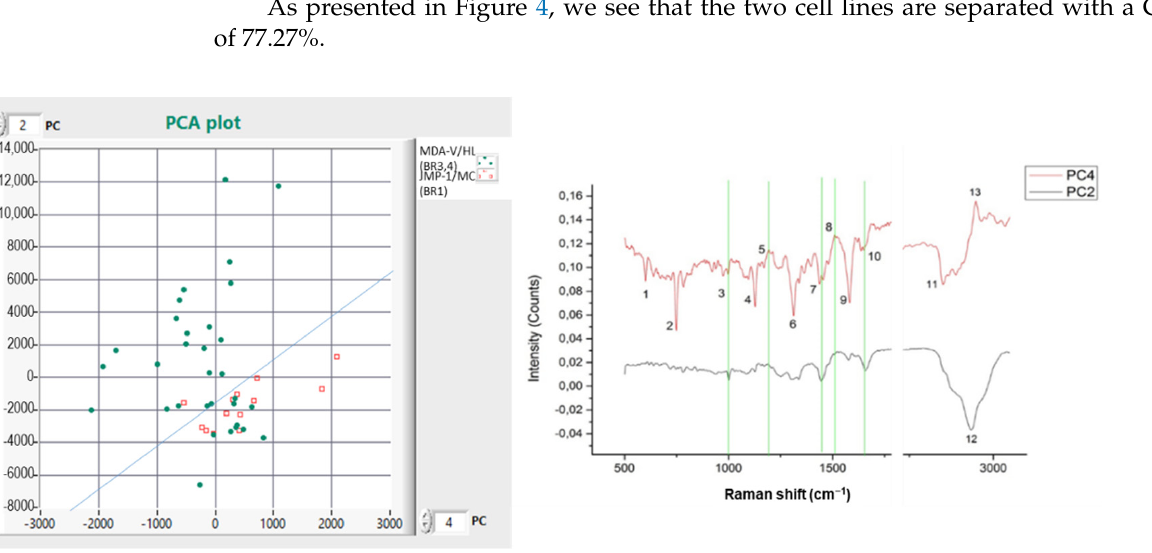
Figure 4. ( left ) Comparison between experiments BR1 (JMP-1/MCL NHL) and BR3,4 (MDA-V/HL) cell lines; ( right ) PCA Raman spectra showing the cell lines differences. Further, the major Raman peaks identified are presented in Table 3. Major Raman peaks found in PCA between BR1 and BR3, 4. In red color and with an aster- isk superscript the temperature dependent Raman peaks are presented. No